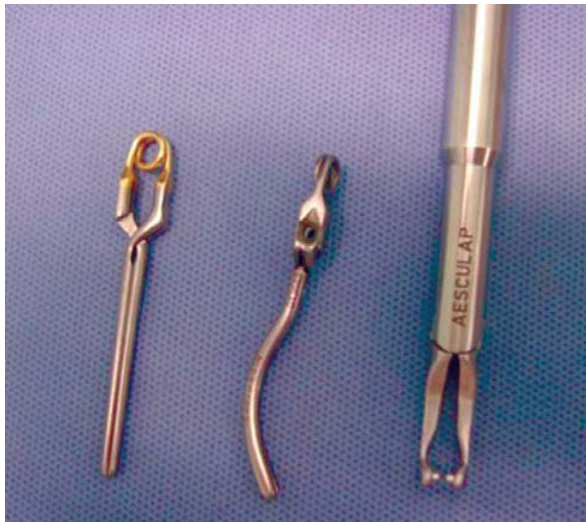
Fig. 2 - Pinças de bulldog para procedimentos videolaparoscópicos